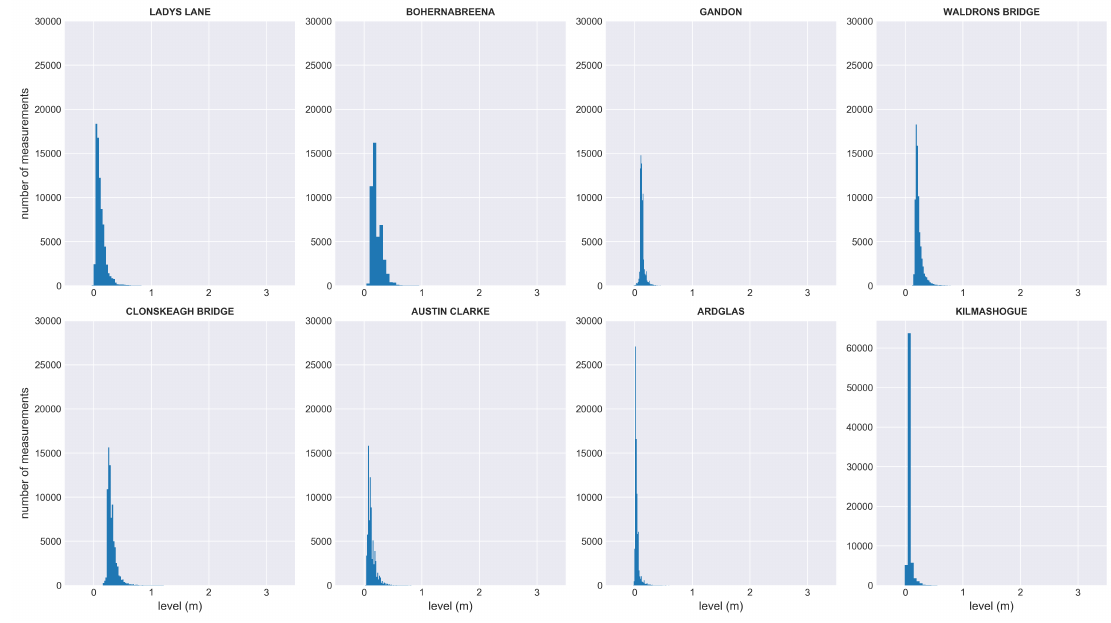
Figure 5. Distribution of all valid measurements from eight sensor units. Invalid values from Bohernabreena site are not